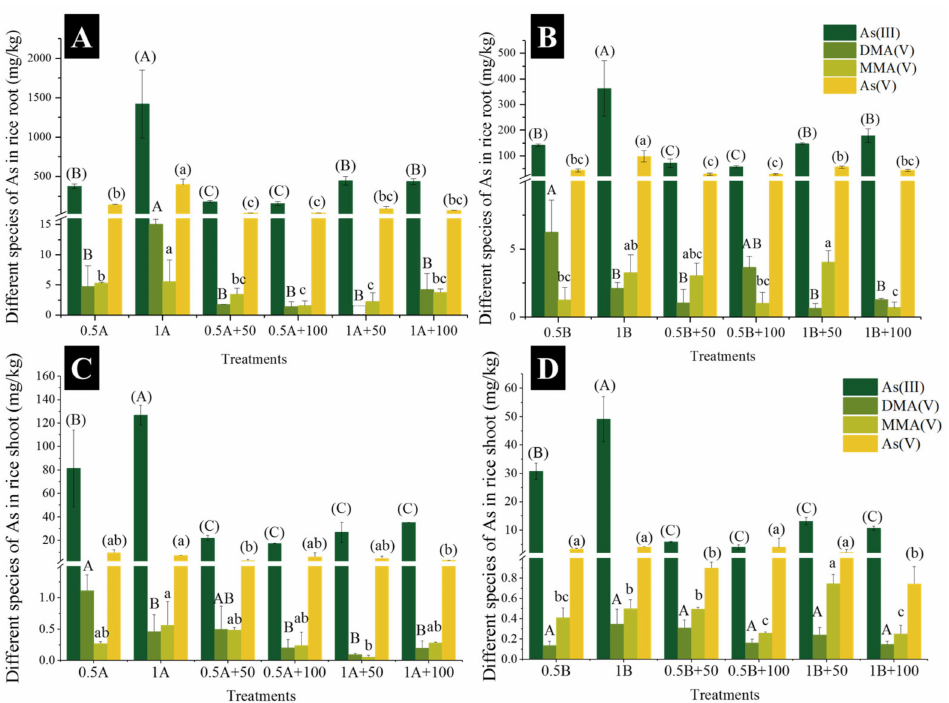
Figure 2. The concentrations of different species As in rice roots ( A , C ) and shoots ( B , D ). Different lowercase letters indicate significant differences between different treatments ( p <